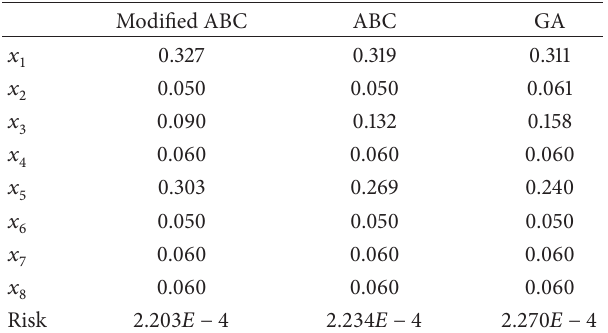
Table 5: The comparison of the modified ABC, ABC, and GA ( 𝑢 0 = 1.75 ). 0.09 , ℎ 0 =